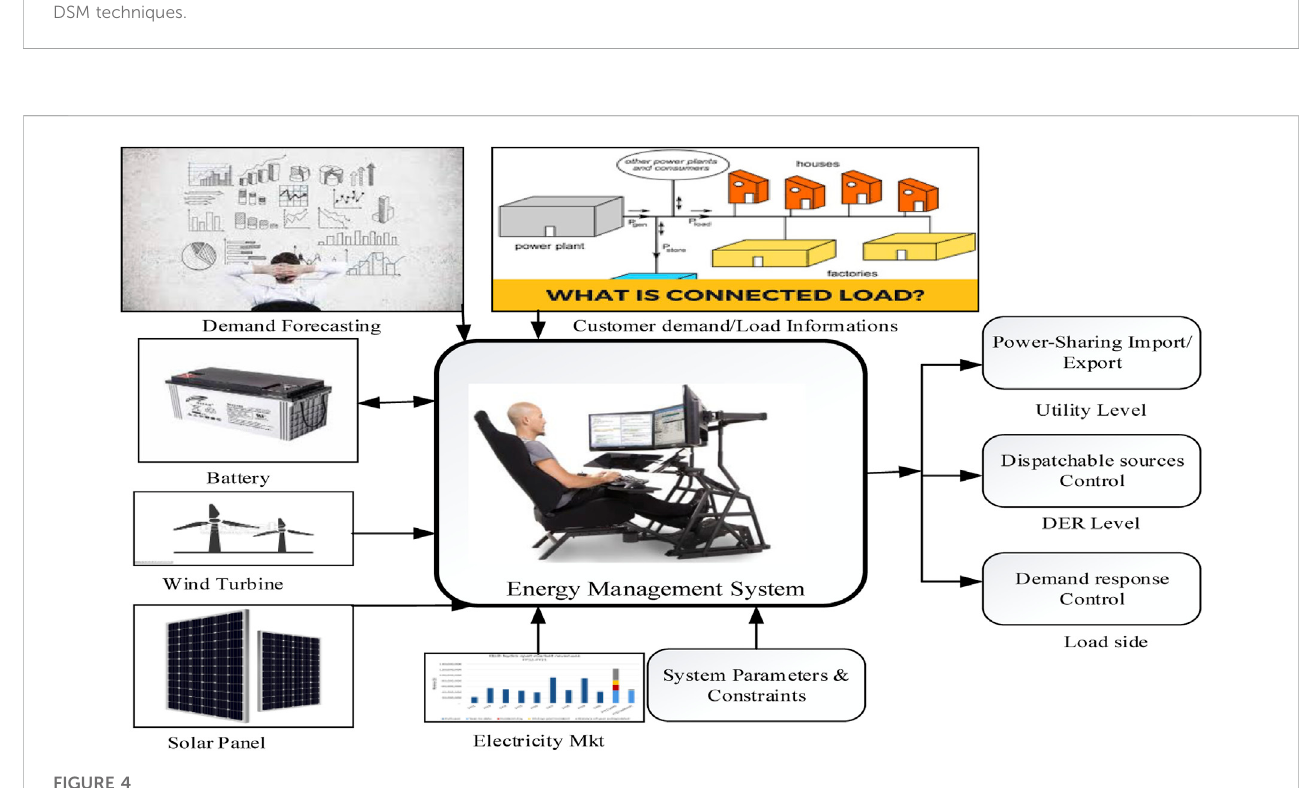
FIGURE 4 Microgrid